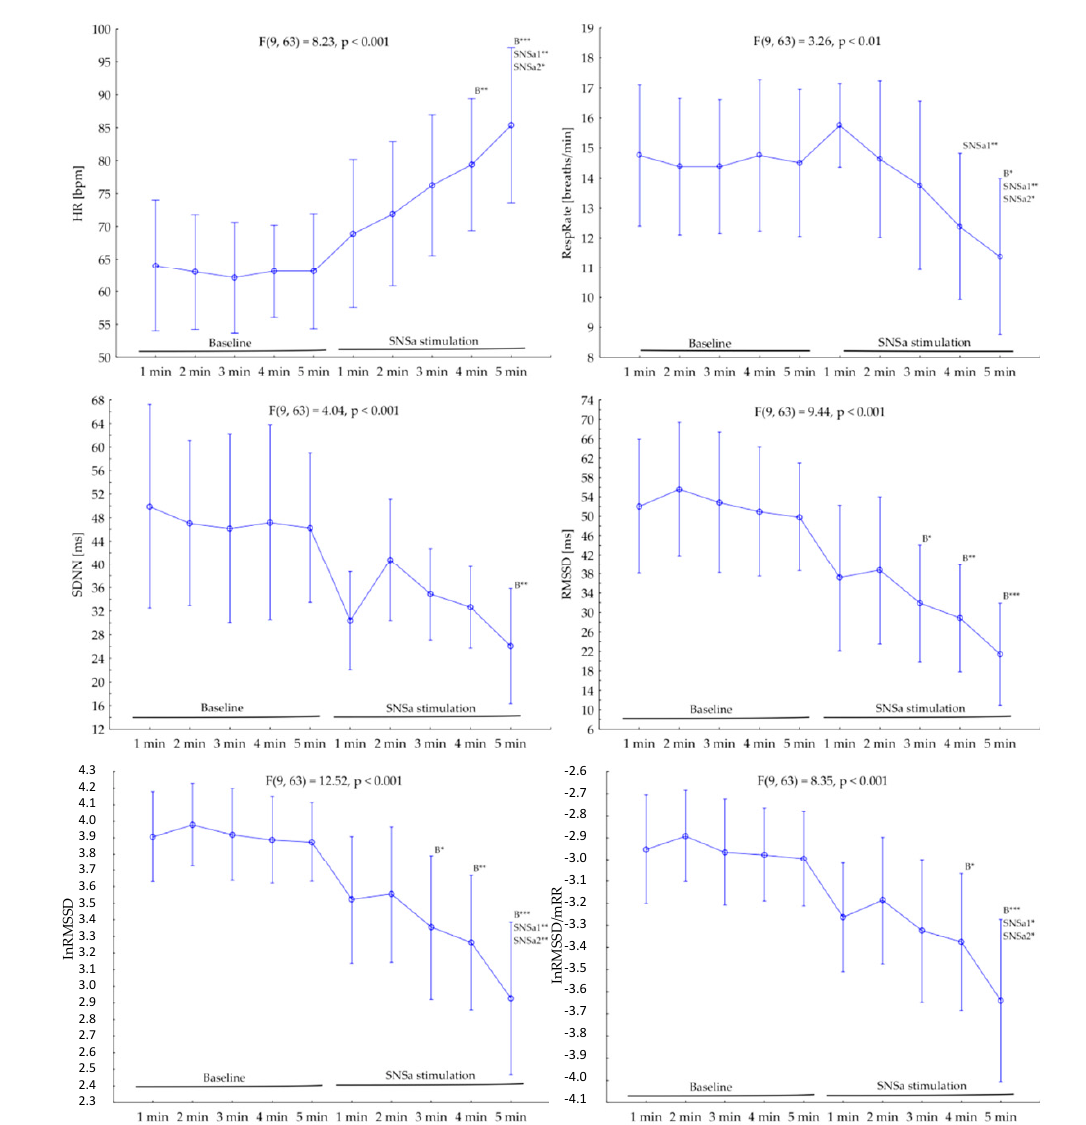
Figure 1. The group changes in heart rate (HR), respiratory rate (RespRate), and time-domain heart rate variability (HRV) parameters minute by minute during the Baseline and sympathetic nervous system activity (SNSa) stimulation recordings. B—significant di ff erence versus Baseline (all minutes), SNSa1—significant di ff erence versus the 1st min from SNSa stimulation, SNSa2—significant di ff erence versus the 2nd min from SNSa stimulation, * p < 0.05, ** p < 0.01, *** p <